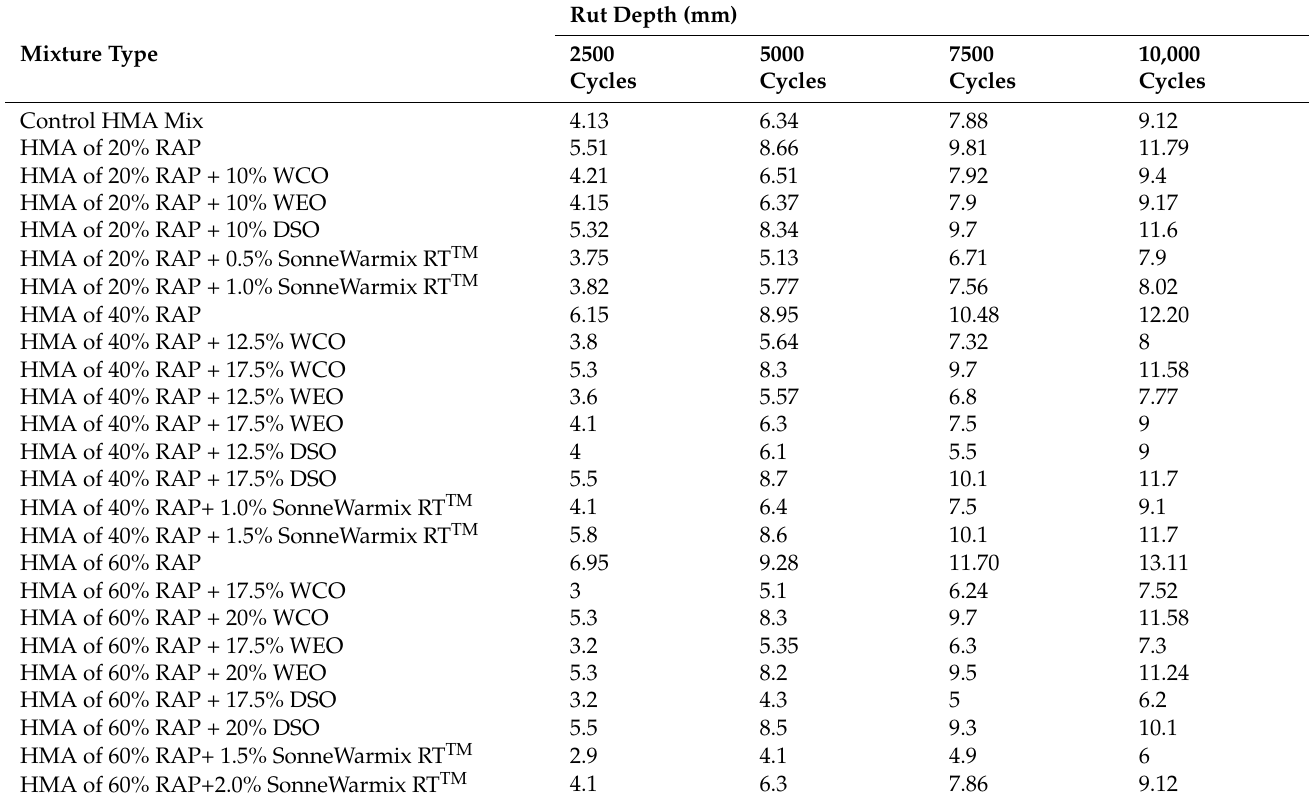
Table 21. Rutting depth for the control and rejuvenated HMA average